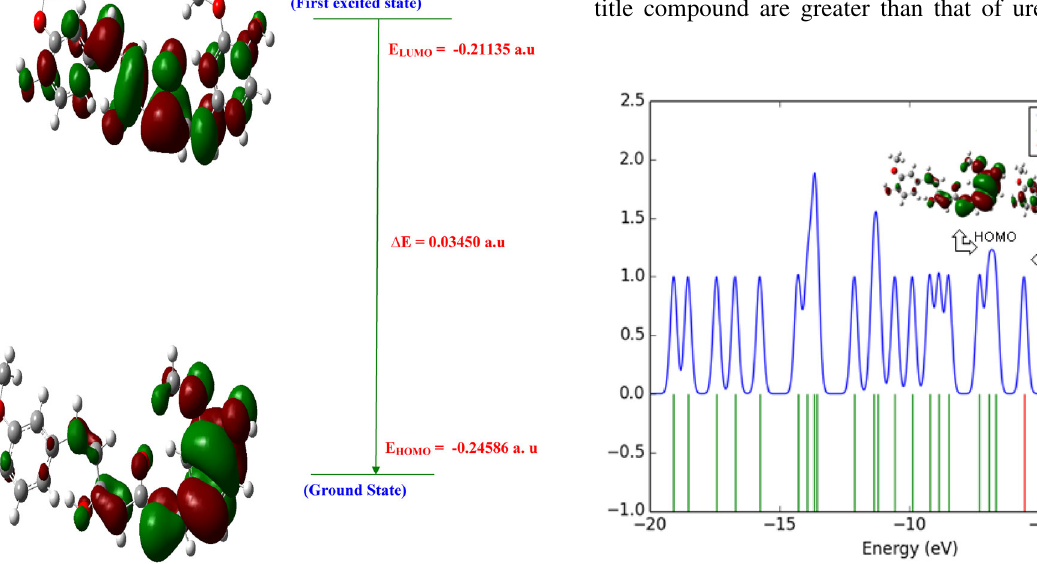
Fig. 11 HOMO-LUMO plot of curcumin Fig. 12 DOS spectrum of